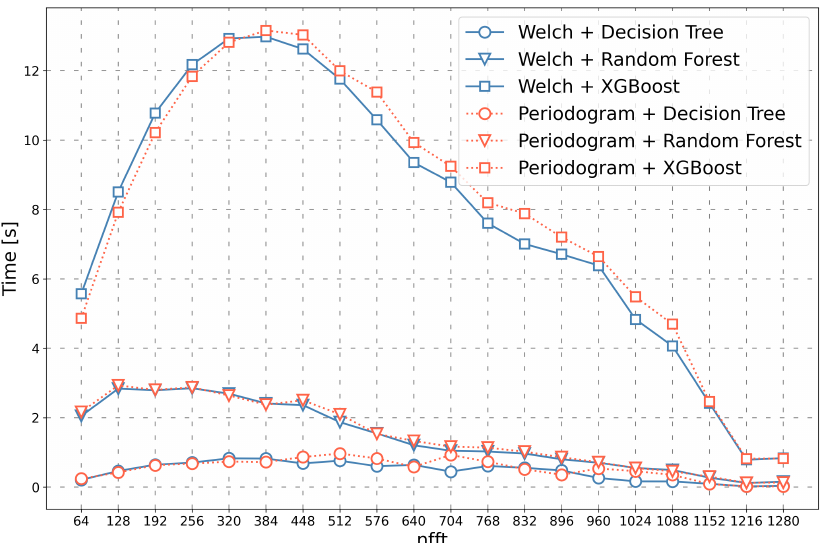
Figure 7. The learning time of classifiers depends on the nf ft values for various transformation methods and